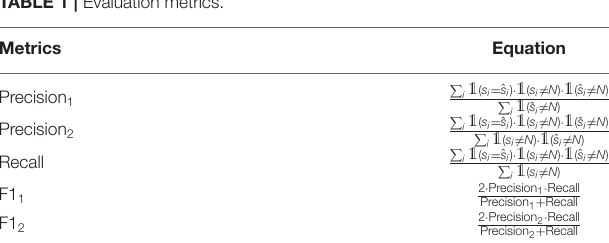
TABLE 1 | Evaluation